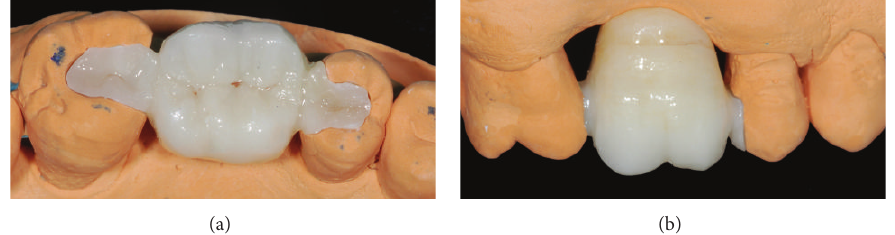
Figure 7: (a) Monolithic zirconia restoration on master cast: occlusal view. (b) Lateral close-up; brown stains were used in the cervical area.